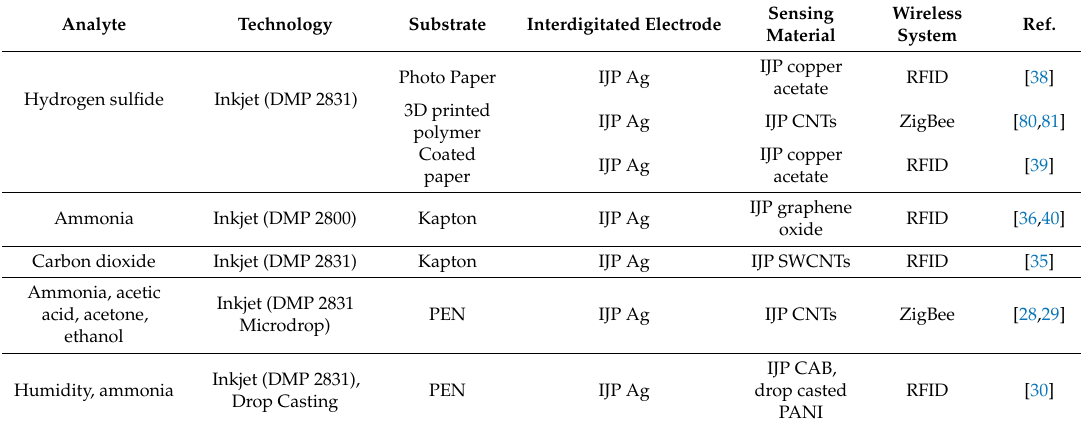
Table 2. Selection of research works reporting on wireless inkjet-printed chemiresistive